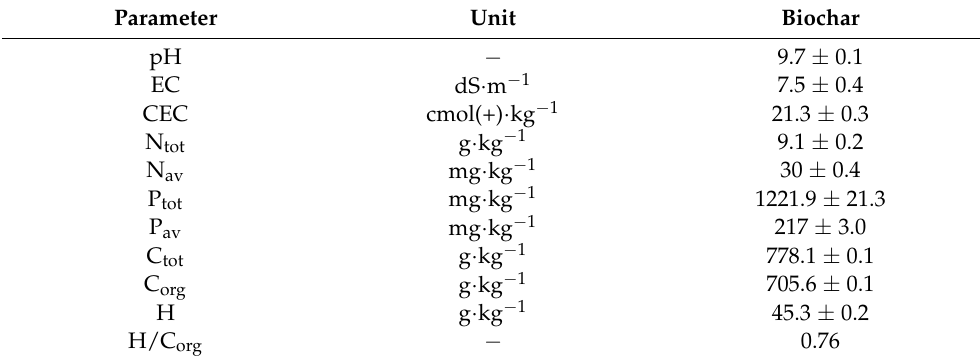
Table 1. Biochar physicochemical characteristics. Each value represents the mean ( n = 8) ± 1